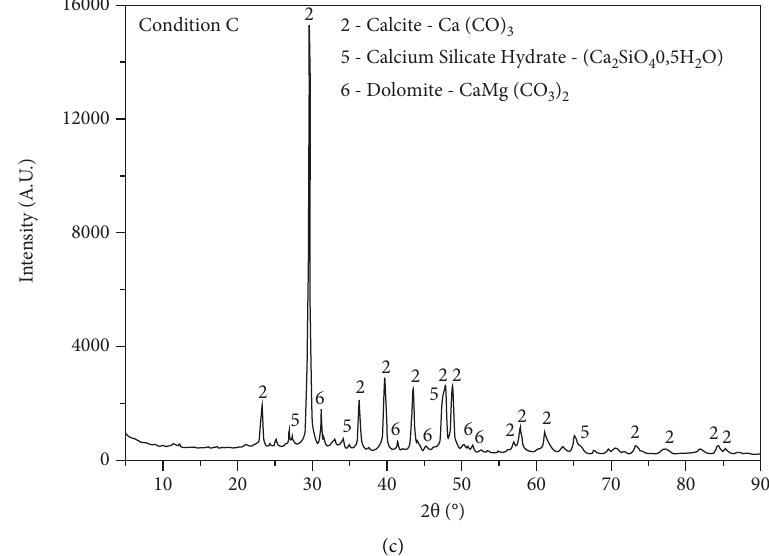
Figure 3: X-ray diffraction pattern of roofing tiles: (condition (a) nonaged tiles; (condition (b) after 100 aging cycles; (condition (c) fast carbonated tiles after 100 aging cycles according to Tonoli et al. [82]. Reproduced with permission from